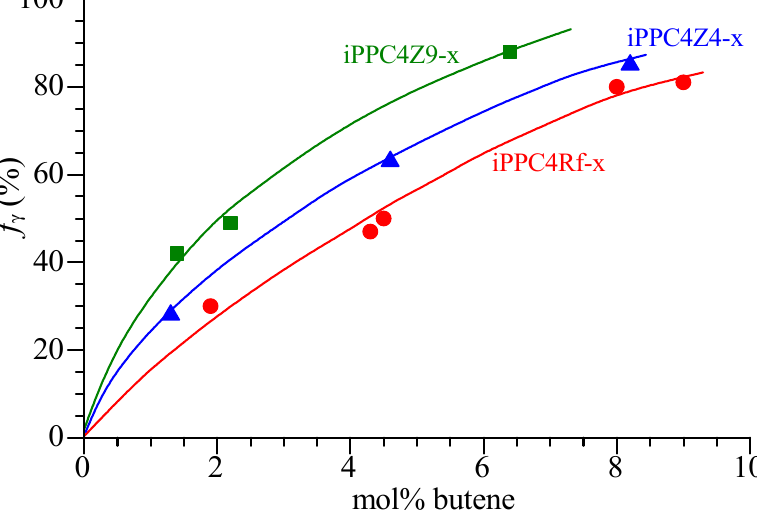
Figure 2. Values of the fraction of γ form that crystallizes in the as-prepared samples of iPPC4 copolymers as a function of butene concentration evaluated from the diffraction profiles of Figure 1. Isotactic samples iPPC4Rf-x with [ rr ] < 0.1 mol% ( • ) and less isotactic samples iPPC4Z4-x with [ rr ] = 2.0–2.4 mol% ( ) and iPPC4Z9-x with [ rr ] = 2.5–3.4 mol% ( ).